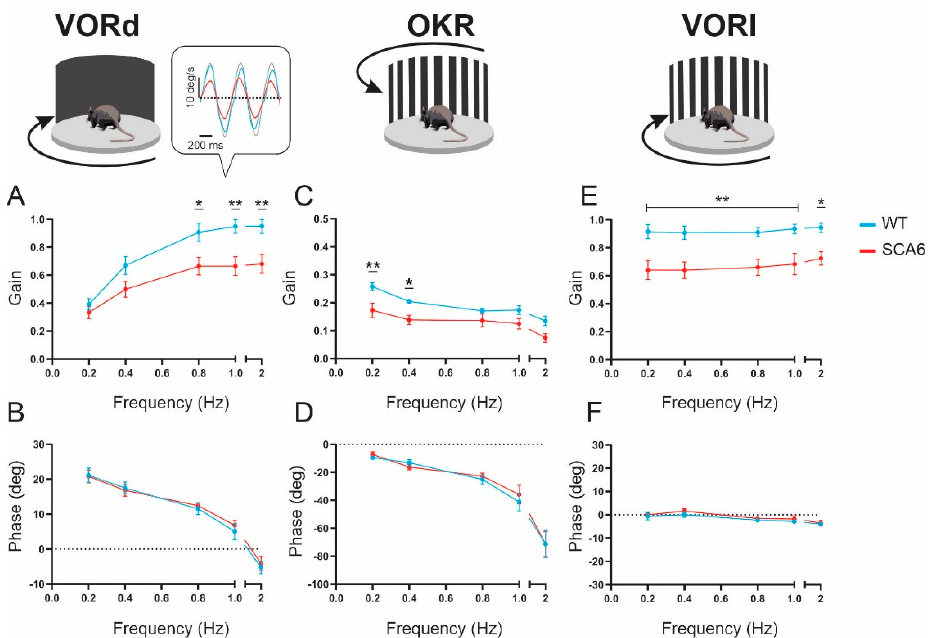
Figure 1. VOR and OKR gains were reduced in SCA6 84Q mice. ( A , B ) VORd gain and phase (mean ± SEM) plotted as a function of frequency for SCA6 84Q mice ( n = 8) and wild-type (WT) mice ( n = 7). VOR gains at 0.8, 1 and 2 Hz were significantly reduced in SCA6 84Q mice. There was no change in phase between two groups. Inset, examples of eye- and head-velocity (grey) traces for WT (blue) and SCA6 84Q mice (red) at 2 Hz. Note, head velocity was inverted to facilitate comparison with eye velocity. ( C , D ) OKR gain and phase (mean ± SEM) plotted as a function of frequency for SCA6 84Q mice and WT mice. OKR gains at 0.2 and 0.4 Hz were significantly reduced in SCA6 84Q mice with no change in phase. ( E , F ) VORl gain and phase (mean ± SEM) plotted as a function of frequency for SCA6 84Q mice and WT mice. VORl gains at all frequencies were significantly reduced in SCA6 84Q mice with no change in phase. Comparisons were two-way repeated measures ANOVA with post hoc Bonferroni ’s test. * p < 0.05, ** p < 0.01.